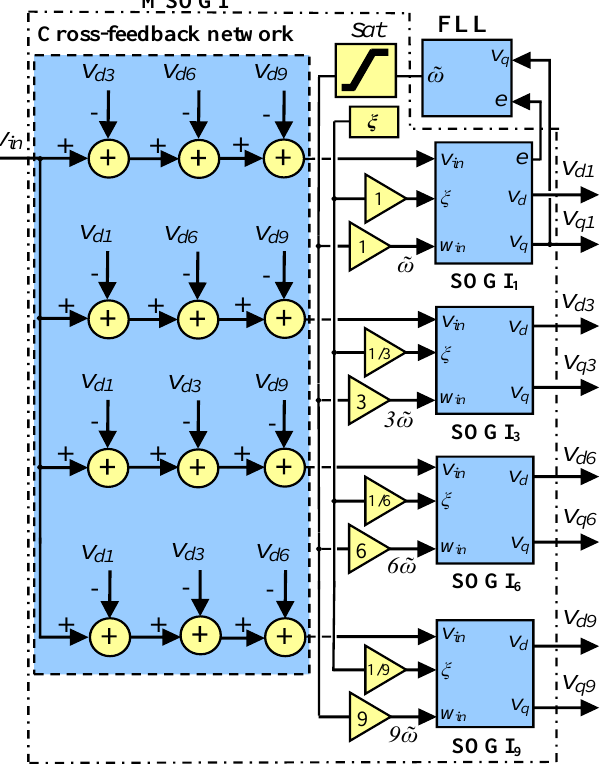
Figure 5. Block diagram of the MSOGI-FLL.